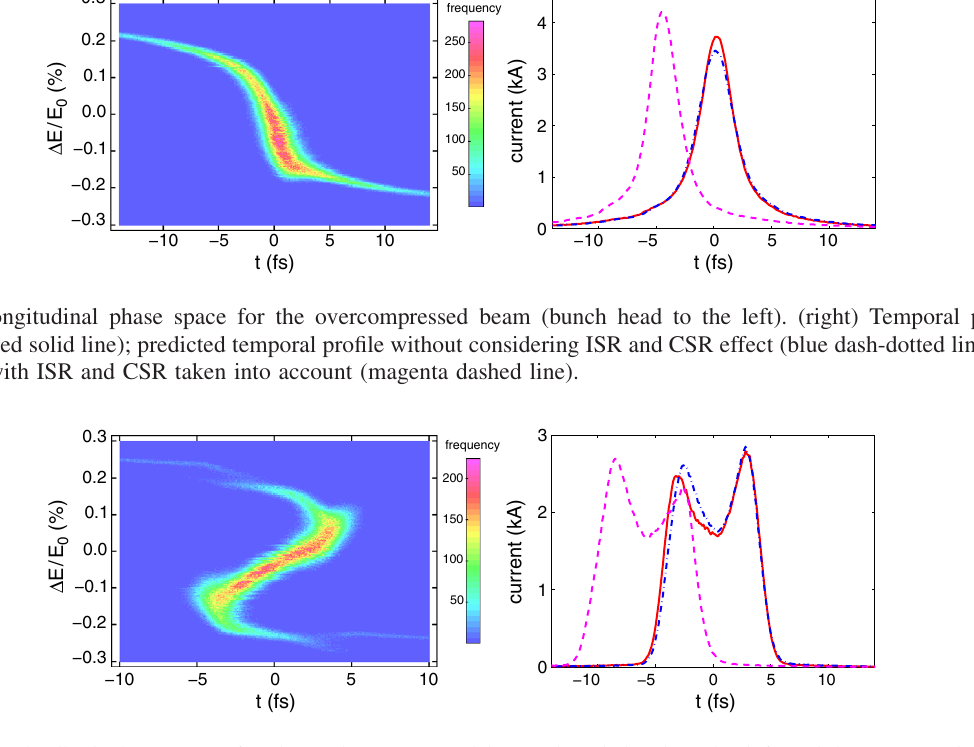
FIG. 4. (left) Longitudinal phase space for the undercompressed beam (bunch head to the left). (right) Temporal profiles: true temporal profile (red solid line); predicted temporal profile without considering ISR and CSR effect (blue dash-dotted line); predicted temporal profile with ISR and CSR taken into account (magenta dashed